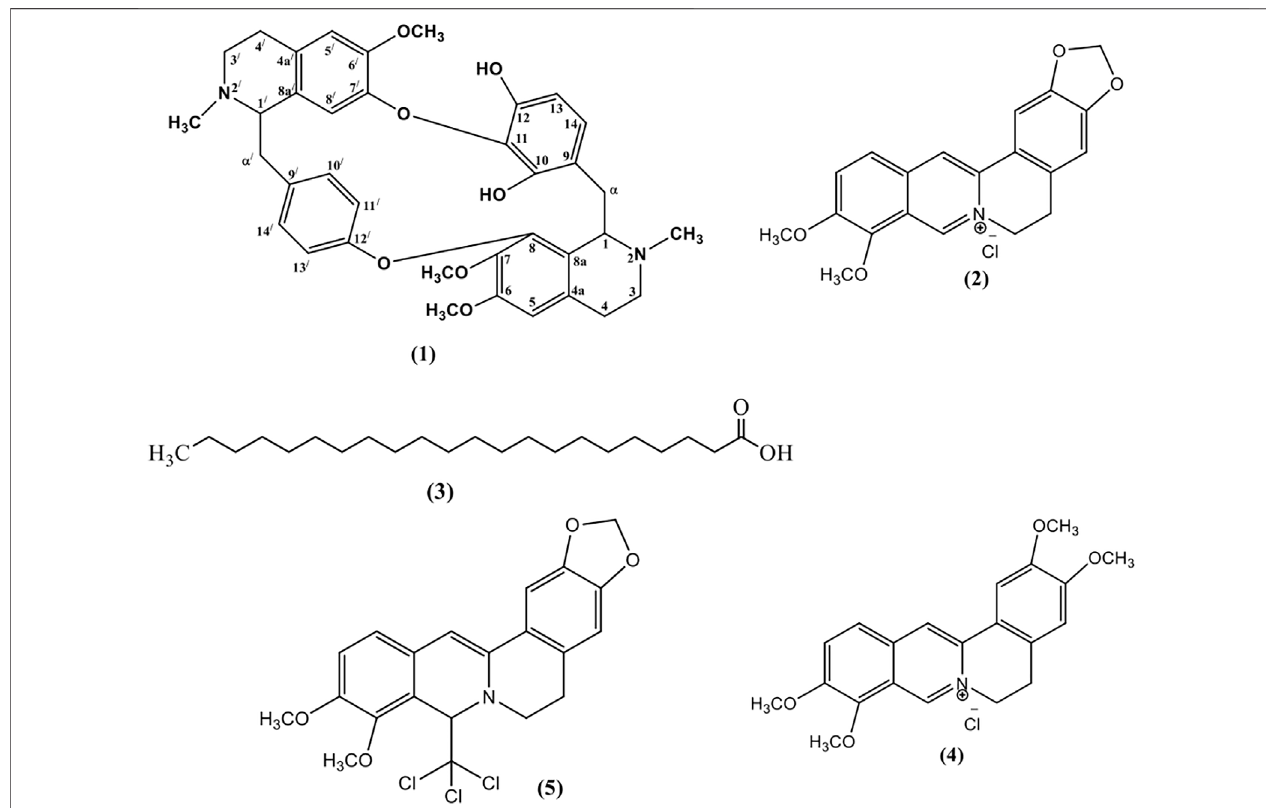
FIGURE 1 | Structures of the isolated compounds 1 –